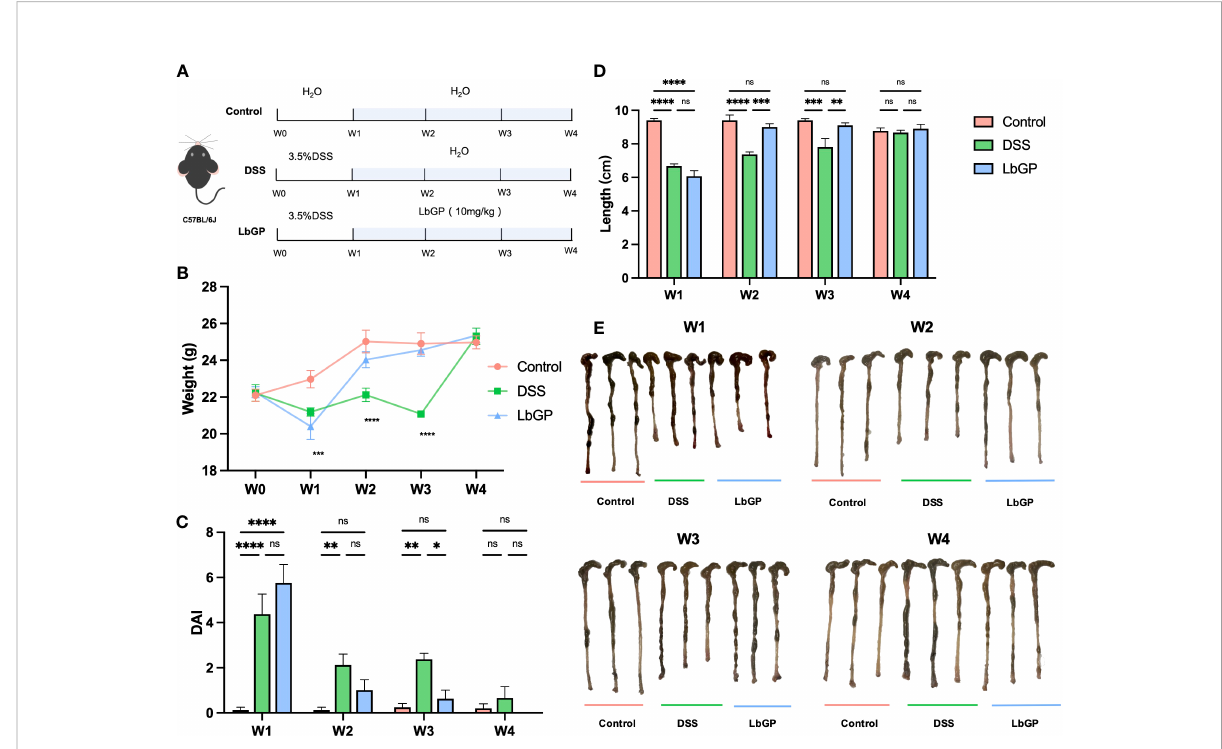
FIGURE 1 LbGP administration reduced the symptoms of DSS-induced acute colitis in mice. (A) Experimental design. (B) Bodyweight (n = 6), (C) disease activity index (n = 6) and (D) length of the colon (n = 3) during the mouse model development. (E) Representative colon pictures from each group at different time points. (*P < 0.05, **P < 0.005, ***P < 0.0005, ****P < 0.0001). “ ns ” means “ no signi fi cant ”